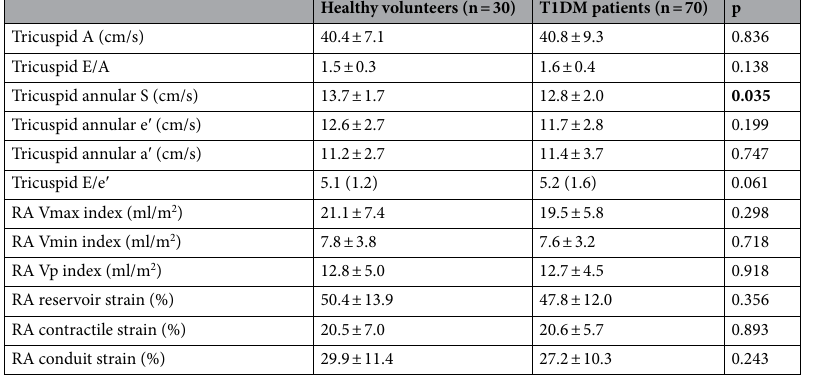
Table 1. Clinical and echocardiographic data of the T1DM population and comparison with healthy subjects. Statistically significant p-values (p < 0.05) are formatted in bold.